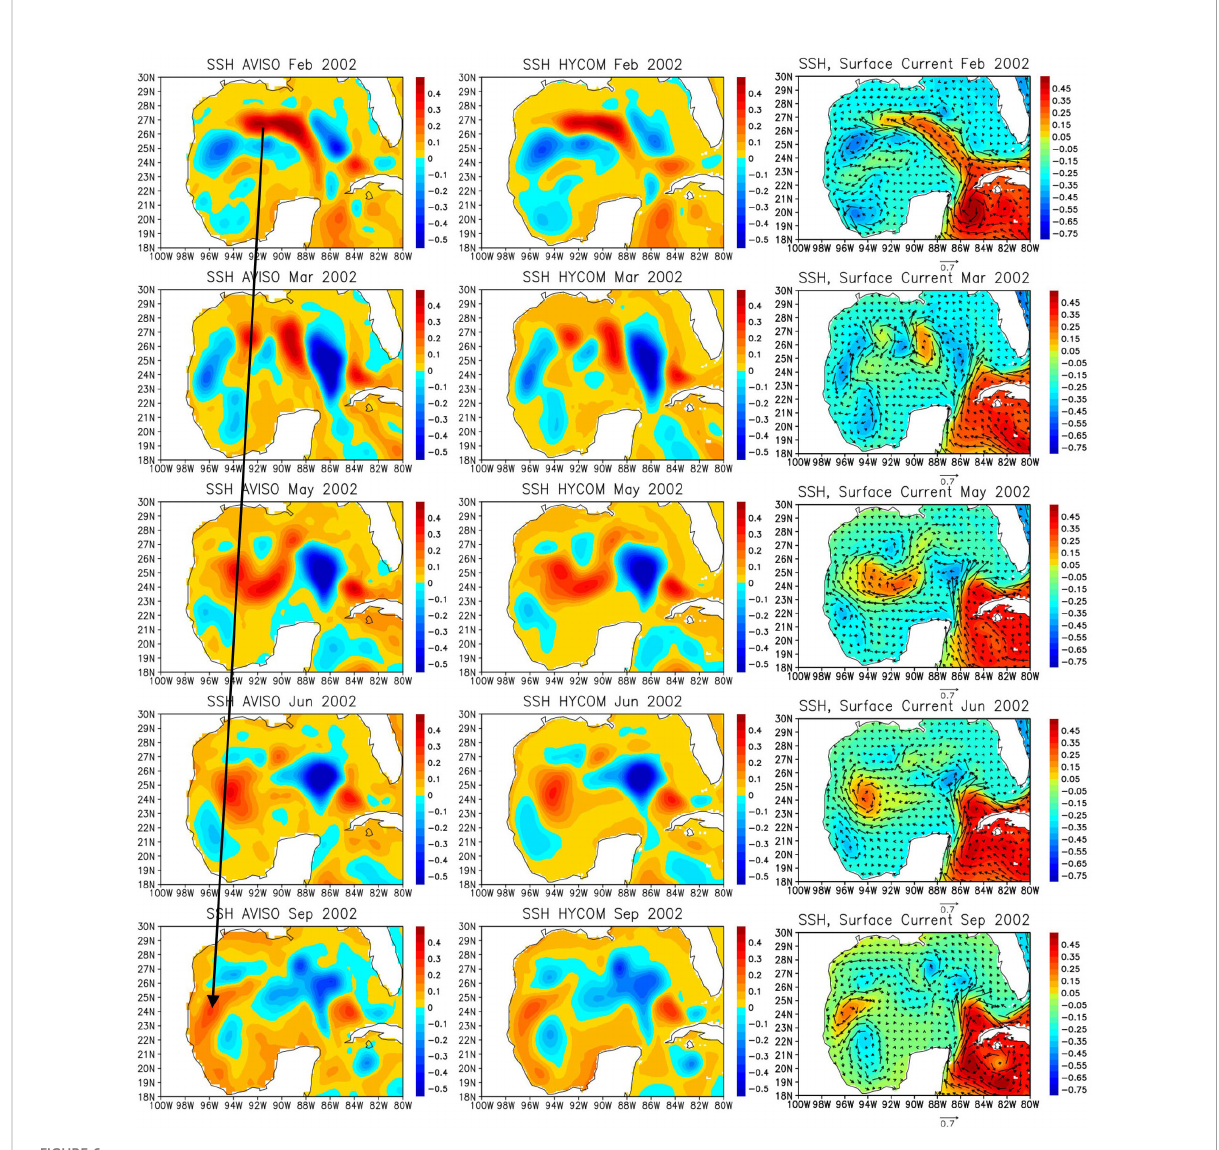
FIGURE 6 Left panels: SSH anomalies in February, March, May, June, and September, 2002 derived from AVISO. Middle panels: Same as left panels except for SSH anomalies derived from the HYCOM reanalysis. Right panels: Same as middle panels except for surface currents and SSH